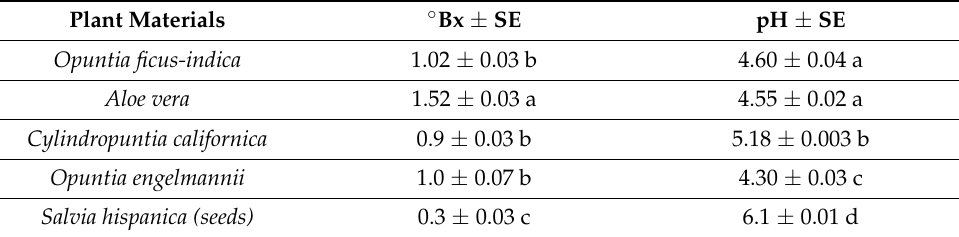
Table 1. ◦ Bx and pH values of mucilage’s extract from different plant species. The data represent the mean value ± SE. ( n = five biological replicates). Different letters indicate significant differences ( p < 0.001; Tukey’s